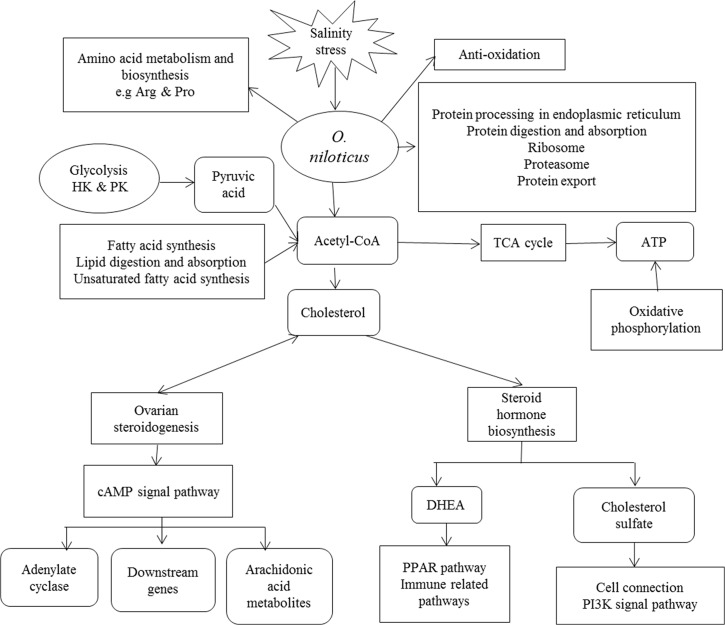
Summary of the transcriptional changes of O. niloticus is shown under the salinity domestication.The right-angle quadrilateral represents the pathways, and the rounded quadrilateral represents the important intermediates.